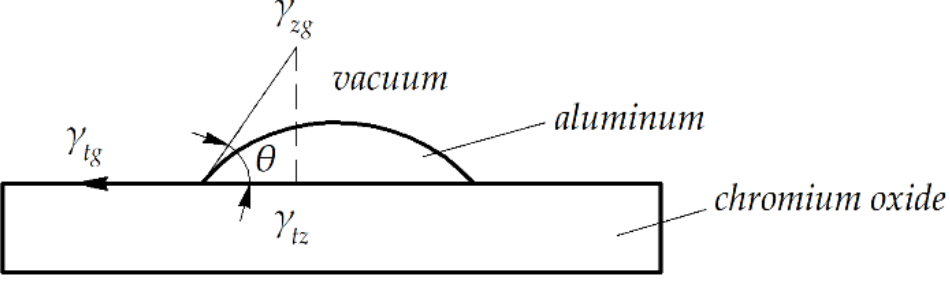
Figure 7. Geometrical representation of the equilibrium of liquid aluminum on the solid surface of chromium oxide.